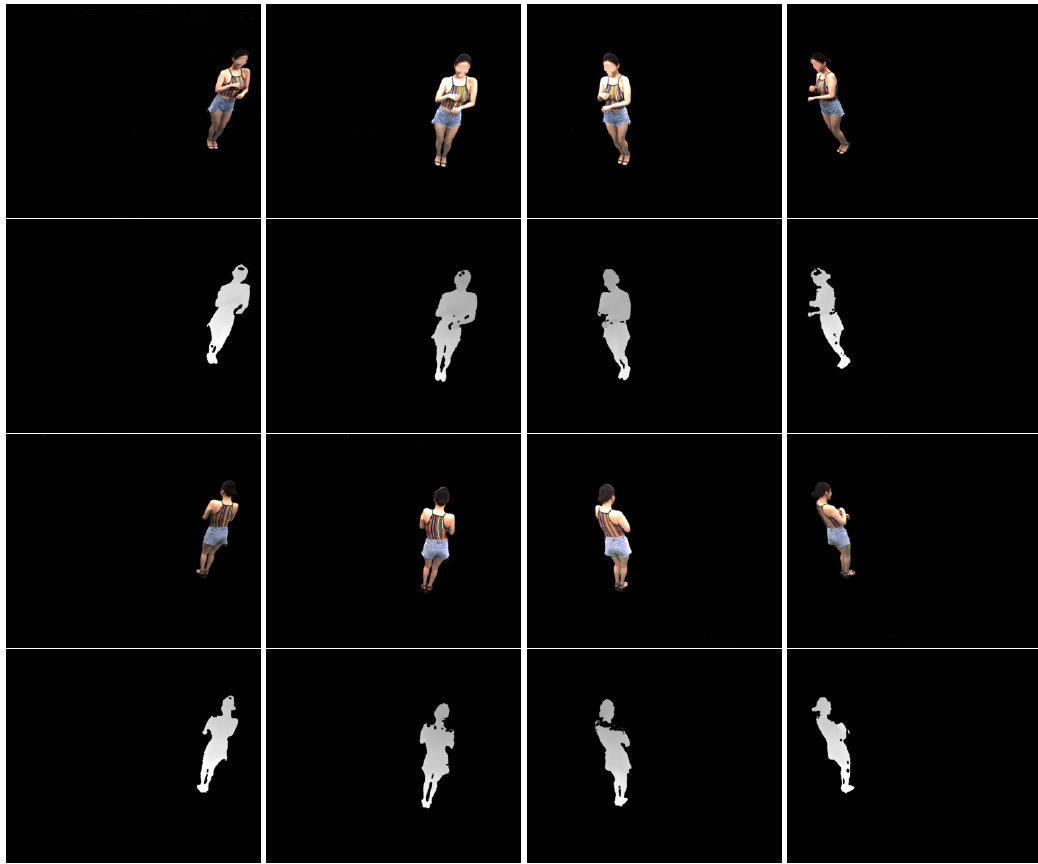
Figure 6. Real multiview RGB-D images [26]. ( First and third rows ): Color images of the model. ( Second and fourth rows ): Depth images of the model. The intensity of the depth images is linear with depth values. The face regions in the front views have been blurred to protect the model’s